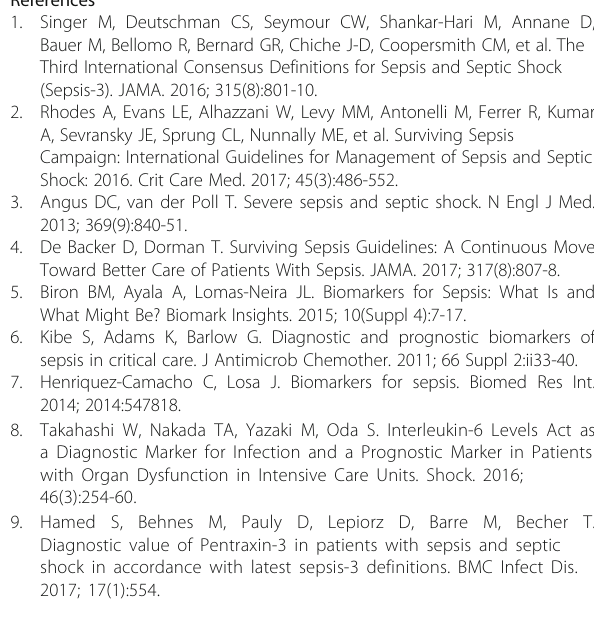
ml, respectively (Figure 1). Serum IL-6 levels could discriminate sepsis (AUC, 0.97-1.00, p<0.001; cut-off value, 5.89 pg/mL [sensitivity 97.0%, specificity 97.2%]) from controls and could discriminate septic shock (AUC, 0.85-0.95; cut-off value, 53.59 pg/mL [sensitivity 91.8%, specifi- city 63.2%]) from the others (controls and sepsis) (Table 2 and Figure 2). Twenty-eight-day mortality was significantly higher in the high IL-6 ( ≥ 53.59 pg/ml) group than in the low IL-6 (<53.59 ng/ml) group (p=0.002) (Figure 3). IL-6 was an independent risk factor for 28-day mortality among patients with sepsis and septic shock (HR, 1.0004; 95% CI, 1.0003-1.0005; p=0.024) (Table 3). PTX-3 level was not significant in the multivariate Cox regression analysis (HR, 1.003; 95% CI, 0.998-1.008; p=0.095) (Table 3). Both initial